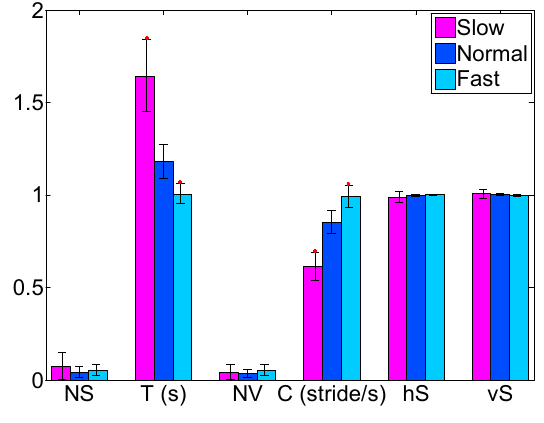
Figure 5. The effect of walking speeds on spatial-temporal gait parameters at slow, normal and fast walking speed, where ∗ indicates the significant differences with normal speed ( p <